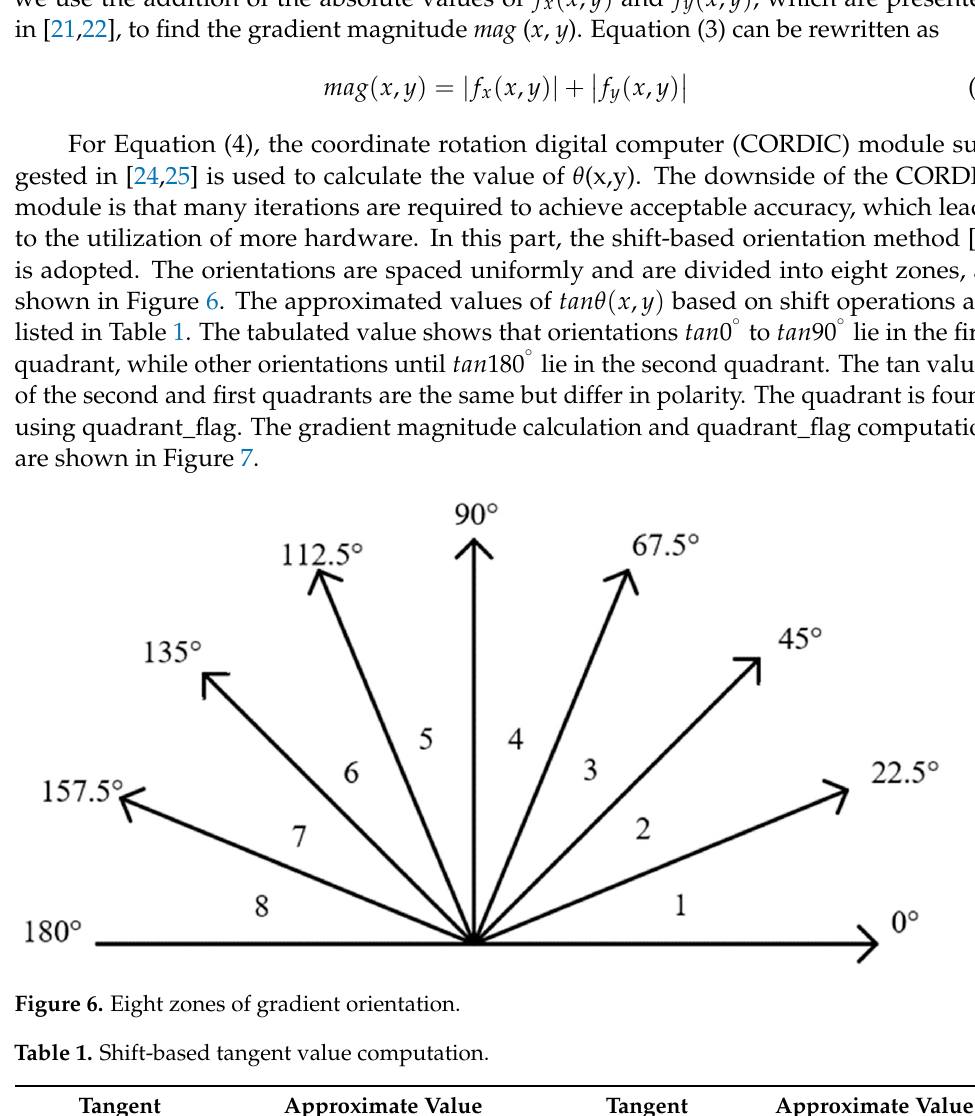
Table 1. Shift-based tangent value computation.